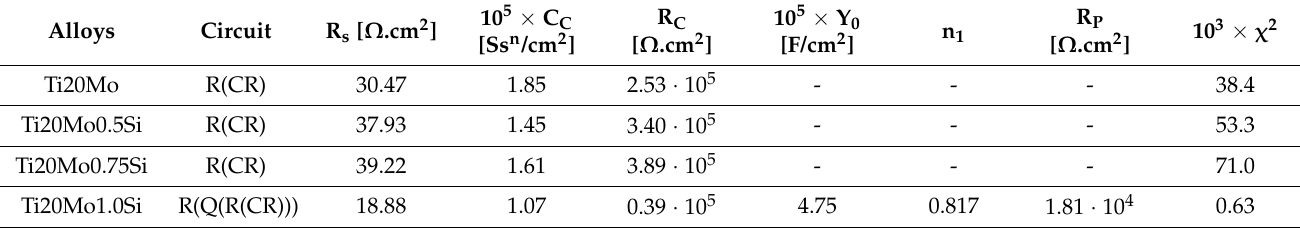
Table 5. The values of the circuit for Ti20Mo, Ti20Mo0.5Si, Ti20Mo0.75 Si and Ti20Mo1.0Si alloys in Ringer solution. Alloys